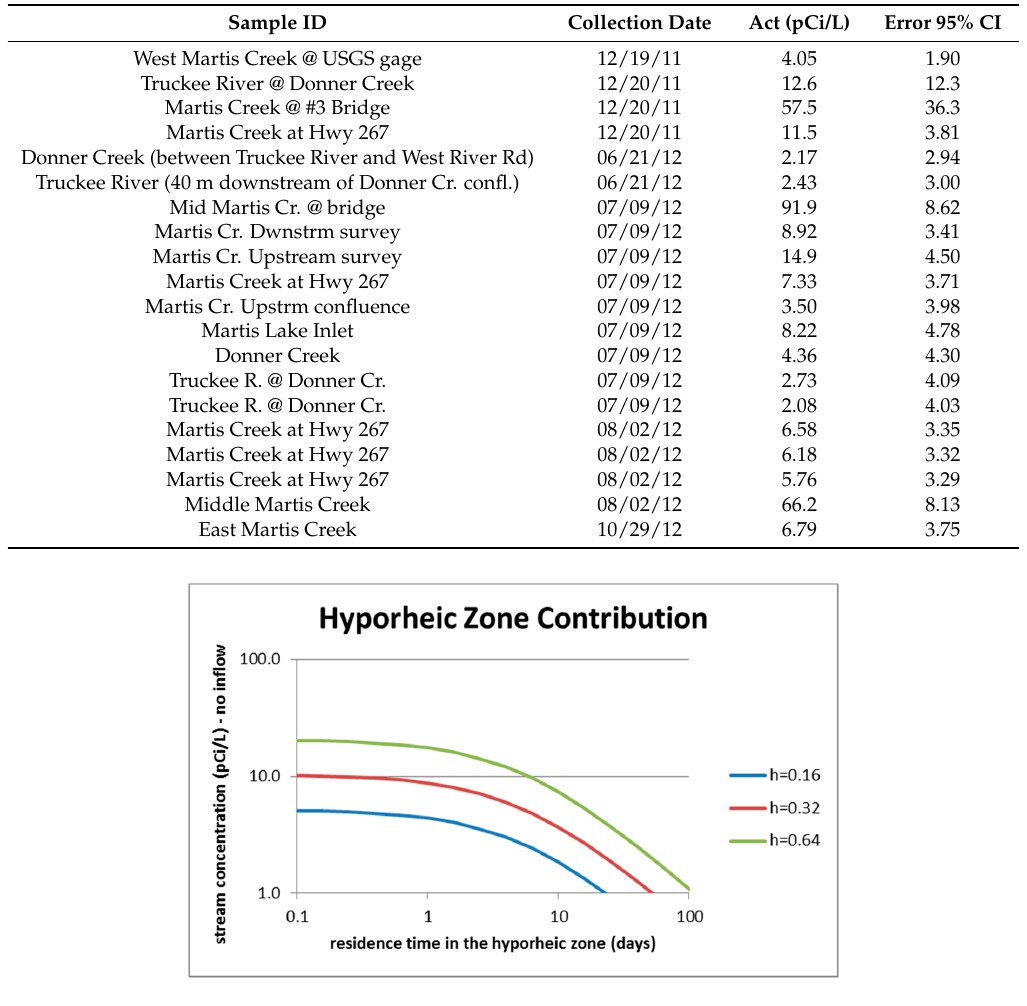
Figure A4. Exponential decrease in the tracer concentrations shown on a plot of log Xe concentration vs distance from Xe tracer injection location. Table A3. Measured 222 Rn activity levels for surface water samples in the Martis Valley region (other than those shown in Table 1) corresponding to locations on Figures 1 and A2.